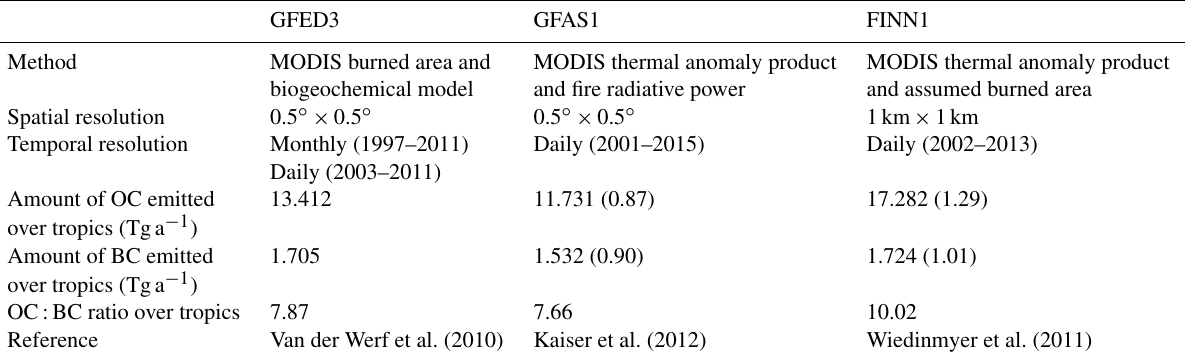
Table 1. Summary of biomass burning emission inventories used in this study: the Global Fire Emissions Database version 3 (GFED3), the National Centre for Atmospheric Research Fire Inventory version 1.0 (FINN1) and the Global Fire Assimilation System version 1.0 (GFAS1). For each emission inventory, the total amounts of black carbon (BC) and organic carbon (OC) aerosol emitted from fires over the tropical region (defined as 23.5 ◦ N to 23.5 ◦ S) are given for the 2003 to 2011 average. Numbers in parentheses give the ratio to GFED3